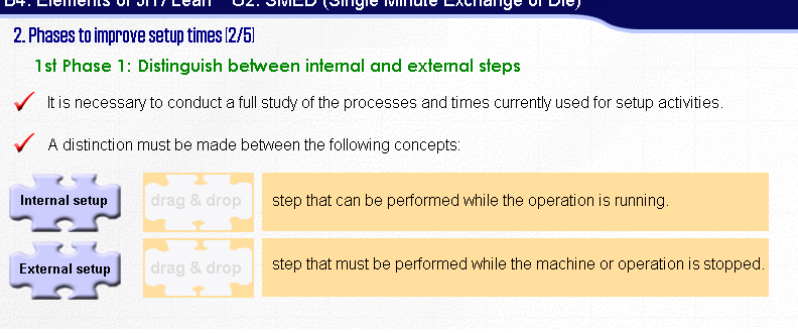
Figure 1. “Example of